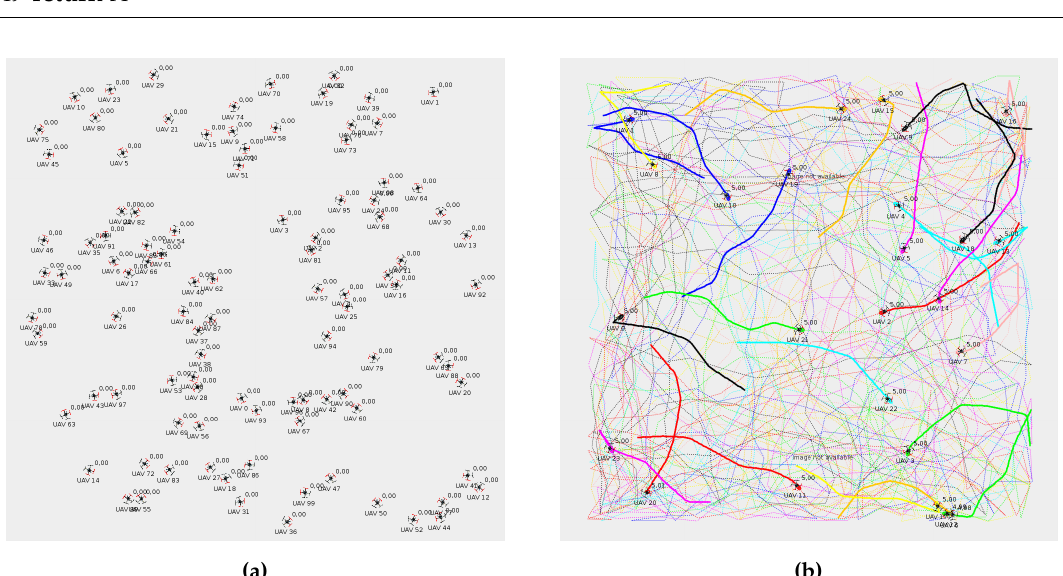
Figure 14. Experiment setup in an area of 5 × 5 km. ( a ) 100 UAVs randomly deployed. ( b ) 25 random Gauss–Markov